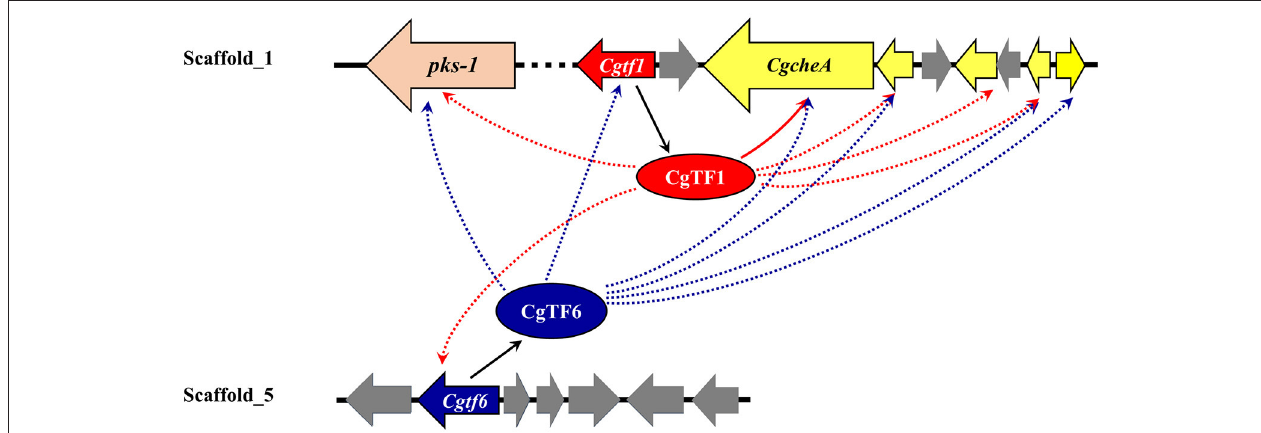
FIGURE 7 | Suggested schematic depiction of the transcriptional regulatory crosstalk between CgTF6 and CgTF1 on ChA biosynthesis in C. globosum . Dashed arrows indicate possible activation or suppression by CgTF1 or CgTF6.